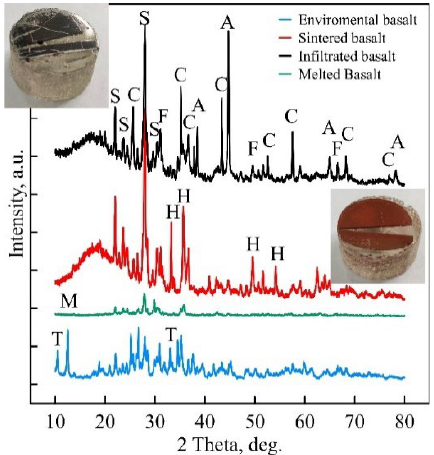
Figure 1. XRD patterns and images of basalt samples: A—aluminum (COD 96-431-3215); C—corundum (COD 96-900-9681); F—Ferrosilite (COD 96-900-0360); S—Anorthite (COD 96-900-0363); H—hematite (COD 96-901-5965); T—tremolite (COD 96-900-0360); M—chamosite (COD 96-900-9234).